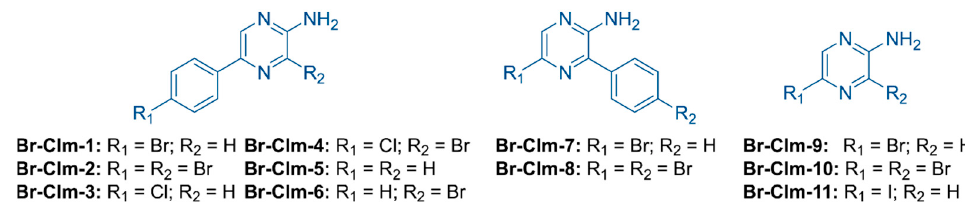
Figure 7. Structures of the screened compounds.